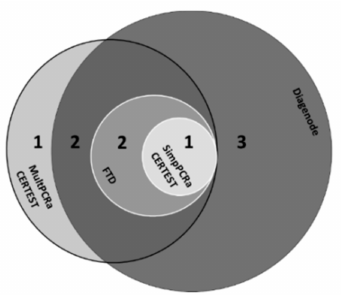
Figure 2. False-negative results for the detection of G. intestinalis using in-house SimPCRa as gold standard (Venn diagram) ( n = 9). Table 5. Cycle thresholds of the nine false-negative samples for G. intestinalis using in-house SimPCRa as gold standard. Samples